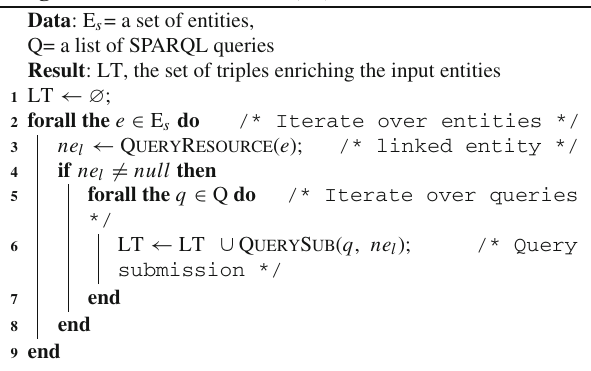
Algorithm 2: Enrichment(E s ) - Semantic